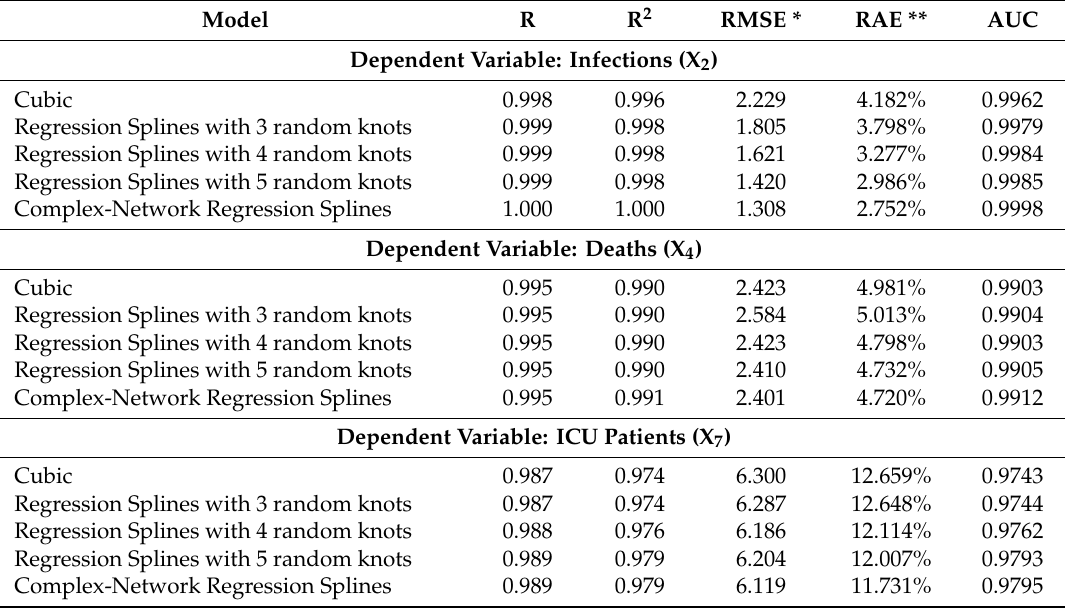
Table 2. Comparison between the polynomial cubic and regression splines fitting